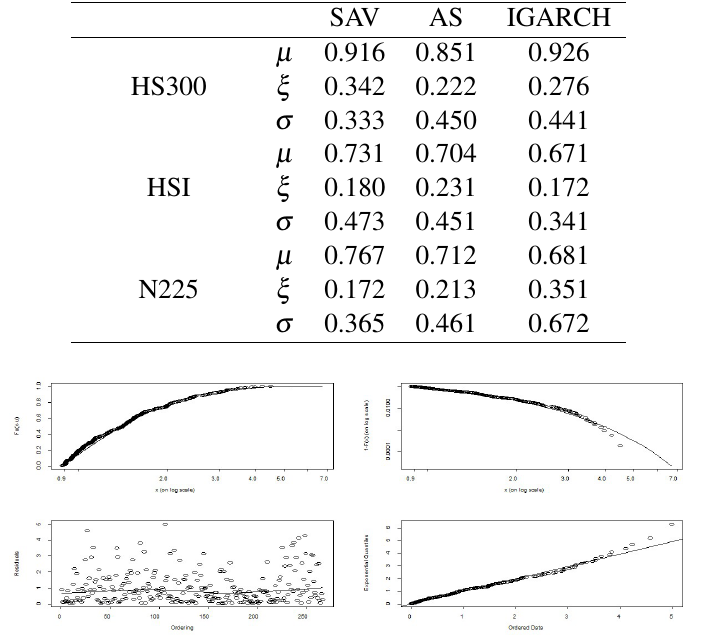
Table 4 POT estimation of the extreme standard residual sequence